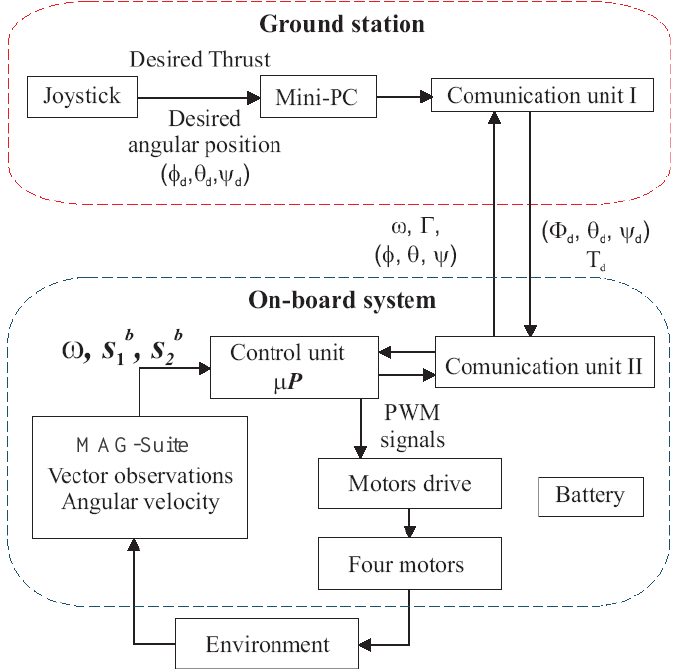
Figure 5. The block diagram of the quadrotor’s attitude control